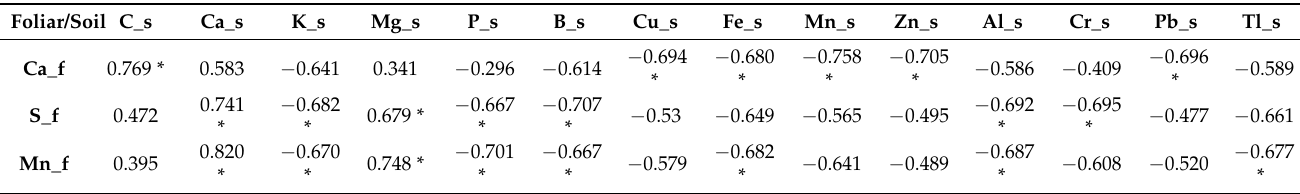
Table 5. Correlating elements between leaf and total soil contents (Pearson’s correlation coefficients). * Higher correlations. (f: foliar; s: